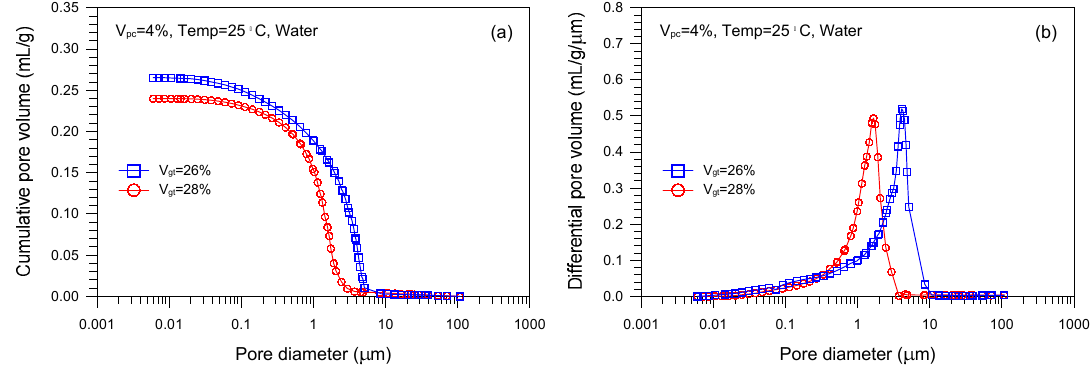
Figure 3. Effect of tailings volume fraction on pore size distribution of cement-stabilized tailings: ( a ) cumulative intrusion curve, ( b ) differential instruction curve. Minerals 2018 , 8 , x FOR PEER REVIEW